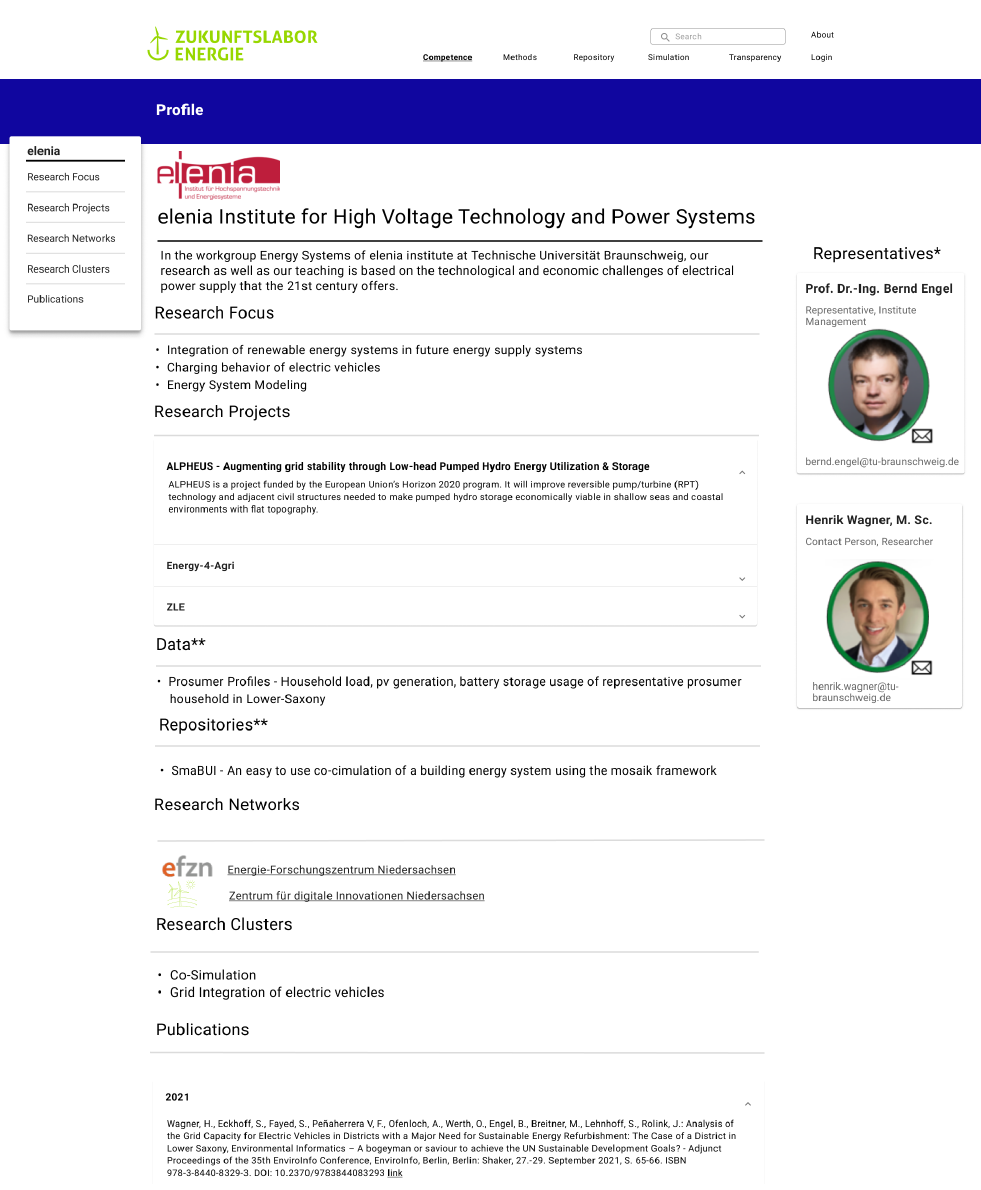
Figure 3. Mockup of the Competence Profile ; * derived from Core and ** derived from Repository